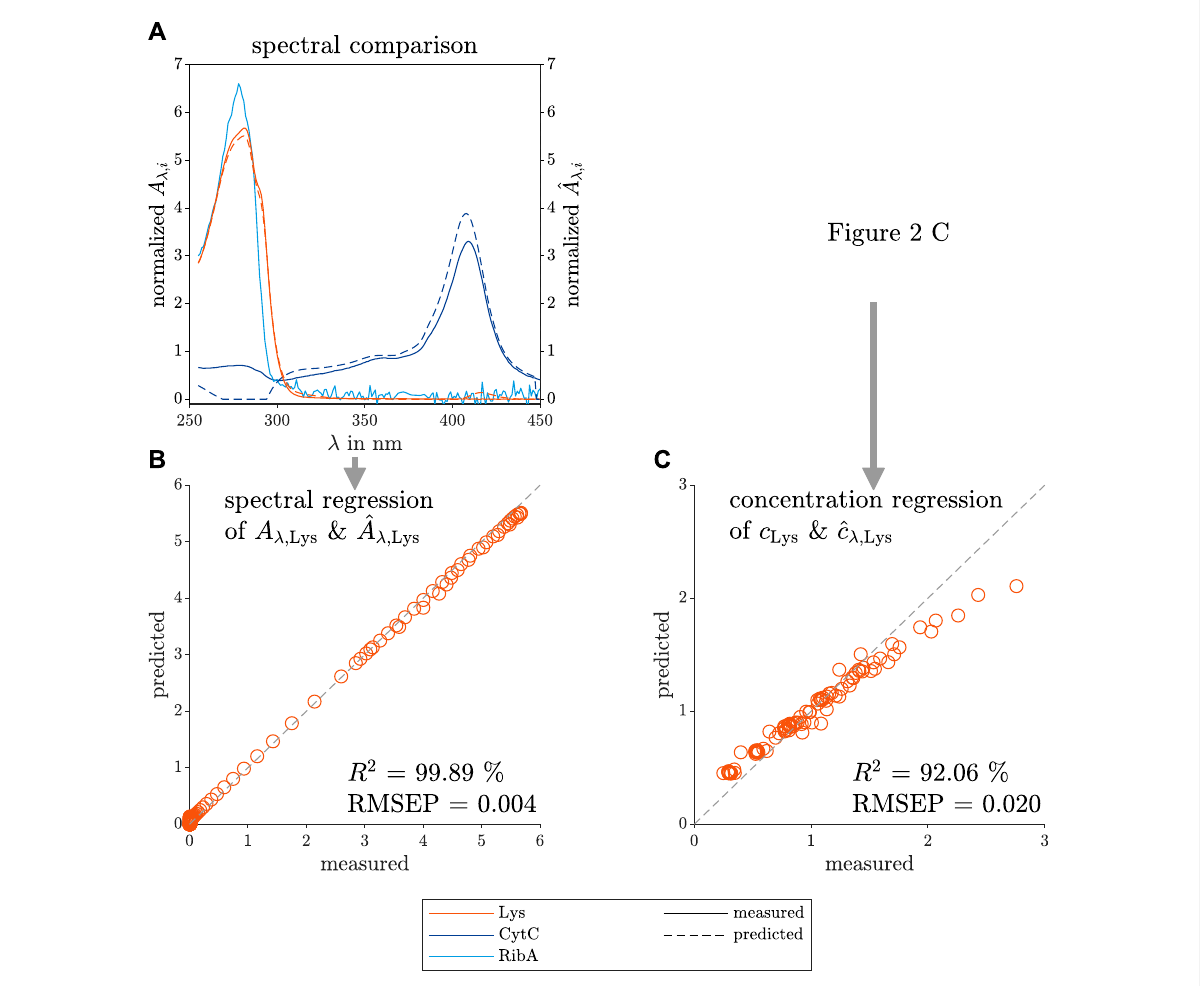
FIGURE 3 Comparison between predicted and measured data of the spectral and concentration loadings of the selective crystallization screening of Lys. The measured reference data (left axis) and the predicted loadings (right axis) are illustrated with solid and dashed lines, respectively. The colors orange, dark blue, and light blue indicate the contaminating species, target species Lys, the model proteins CytC and RibA, respectively. The predicted spectral loadings, and the measured reference data are used to calculate the mean-normalized predicted and measured absorption ( ^ A λ , i & A λ , i ) which are plotted over the wavelength λ for each species i in (A) . The predicted absorption ^ A λ , Lys of Lys is shown over the measured absorption A λ ,Lys of Lys in (B) . Figure 2C is used to calculate the mean-normalized predicted concentration loadings ^ c Lys and the measured concentration data c Lys of Lys in (C) . The gray dashed lines visualize the ideal fi t of the predicted to the measured data (B,C) . The calculated, high coef fi cient of determination R 2 values support the PARAFAC model